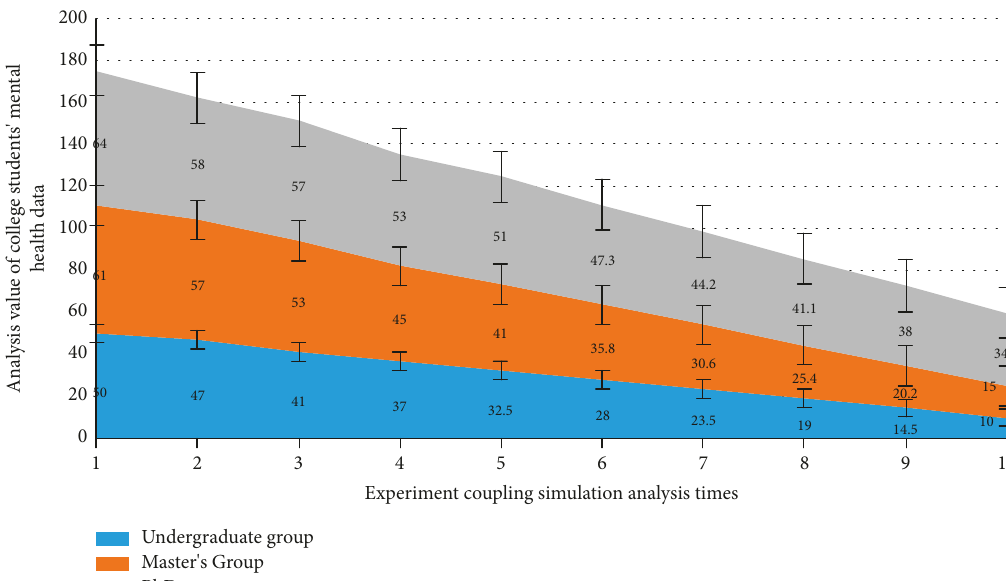
Figure 5: Data analysis results after the same model analyzing the mental health of different college